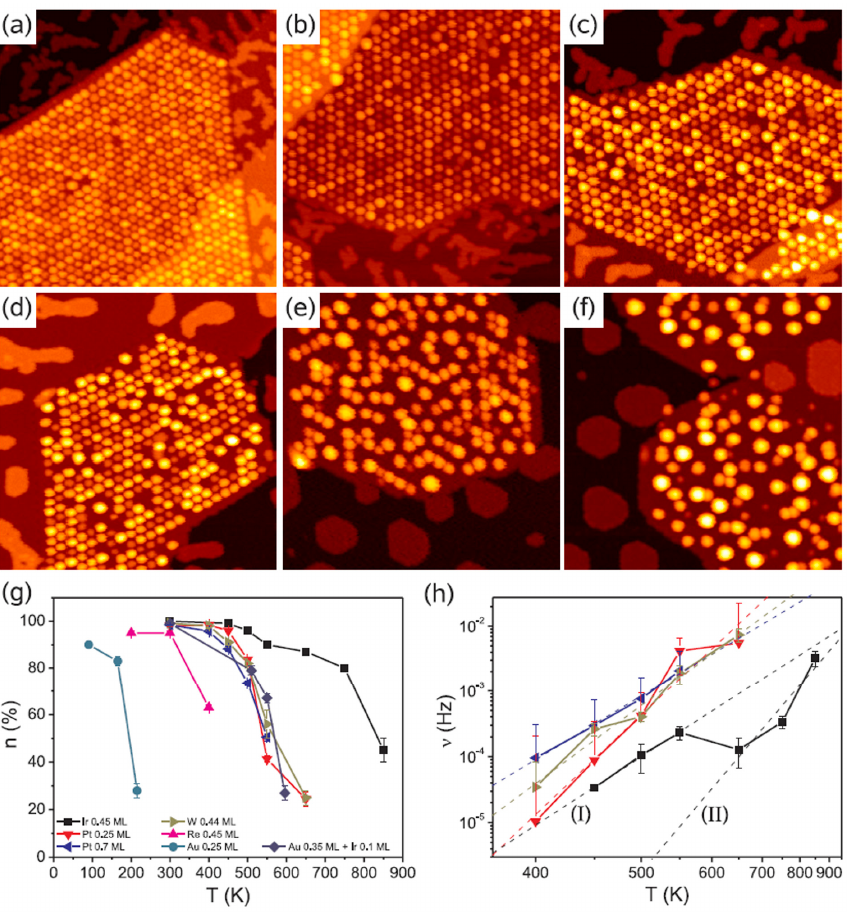
Figure 13. Scanning Tunneling Microscopy images (70 nm × 70 nm) of ( a ) 0.25 ML Pt deposited on graphene/Ir(111) maintaining the substrate at 300 K. This sample was then annealed for 300 s at ( b ) 400 K; ( c ) 450 K ( d ) 500 K; ( e ) 550 K and ( f ) 650 K; ( g ) Plot of n (occupation probability of the moiré cell by a particle) versus the annealing temperature T; ( h ) Arrhenius plot of particle jumping rate ν (T). Lines represent fits for the hopping rate with diffusion parameters as shown in Table 3. Reproduced from Reference [64] with permission from IOPscience.